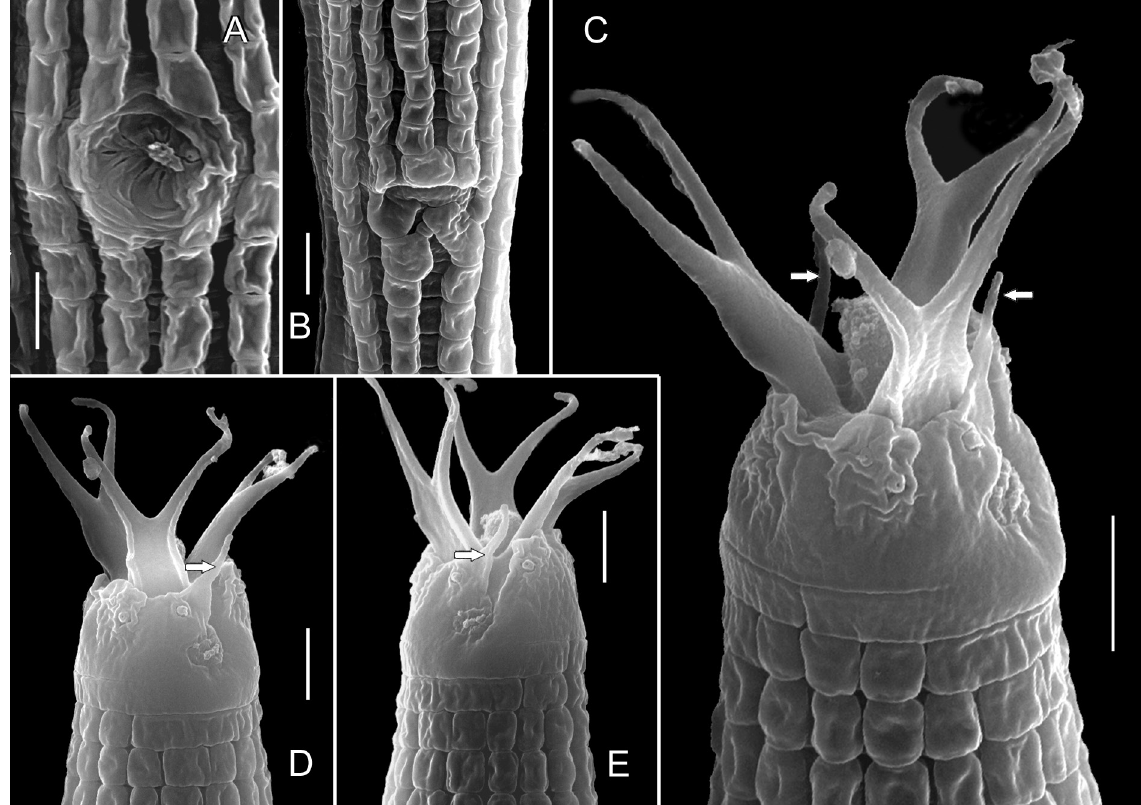
Fig. 3. Stegelleta laterocornuta sp. nov., SEM micrographs. A . Vulval opening. B . Anal opening. C–D . Anterior end, left subventral view. E . Anterior end, left lateral view (arrows in C–E point at the long acute tine extending along the primary axil on the lateral lips). Scale bars = 2